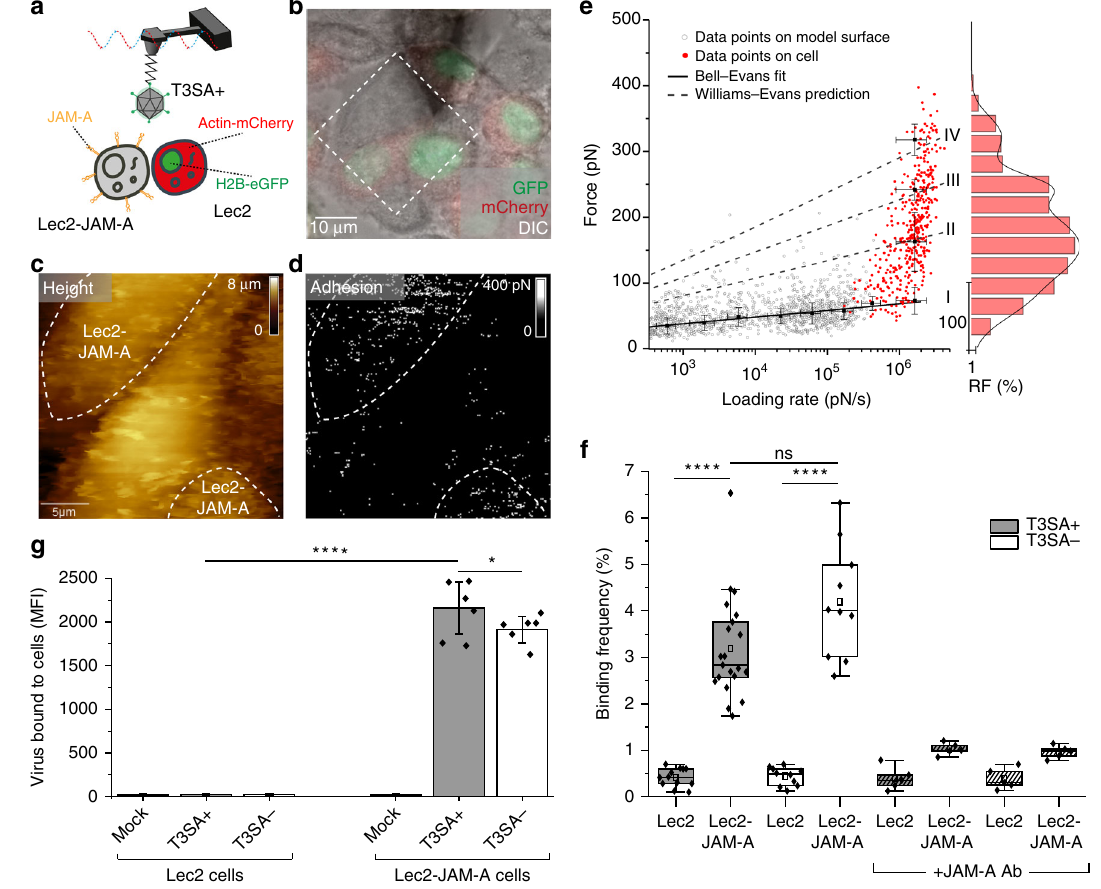
Fig. 5 Probing reovirus binding to JAM-A on living cells. a Combined optical microscopy and FD-based AFM of T3SA + interaction with JAM-A on living Lec2 cells. b Overlay of DIC, eGFP, and mCherry signals of a con fl uent layer of co-cultured fl uorescent Lec2 cells (actin-mCherry and H2B-eGFP) and unlabeled Lec2-JAM-A cells. c , d FD-based AFM topography image ( c ) and corresponding adhesion map ( d ) of adjacent cells indicated in the dashed square in b . The adhesion map shows interactions mainly between T3SA + particles and Lec2-JAM-A cells (white pixels). For higher visibility, the pixel size in the adhesion image was enlarged two-fold. e DFS plot of T3SA + interactions with JAM-A on model surfaces (grey circles, taken from Fig. 4b — upper panel) and living cells (red dots). Histogram of the force distribution observed on cells fi tted with a multi-peak Gaussian distribution ( n = 600 data points) is shown on the side. f Box plot of BF observed for T3SA + (grey) and T3SA − (white) virions, with (hatched lines) and without injection of JAM-A Ab (10 µ g/ml). The horizontal line within the box indicates the median, boundaries of the box indicate the 25th and 75th percentile, and the whiskers indicate the highest and lowest values of the results. The square in the box indicates the mean. For all experiments, data are representative of at least n = 5 independent experiments. g In fl uence of JAM-A on virus binding determined using fl ow cytometry. Cells were incubated with either no virions (Mock) or Alexa Flour 488-labeled T3SA + or T3SA − virions (10 5 particles per cell), and the median fl uorescence intensity (MFI) of cell-bound virus was determined by fl ow cytometry as shown in Supplementary Fig. 3a. Error bars indicate s.d. of the mean value. Experiments were repeated twice ( n = 2 independent experiments, each with duplicate samples). ns, P > 0.05; * P < 0.05; **** P < 0.0001; determined by two-sample t -test in Origin ( f ) and by two-way ANOVA corrected for multiple comparisons using Tukey ’ s test in GraphPad Prism ( g ), respectively. Source data are provided as a Source Data fi